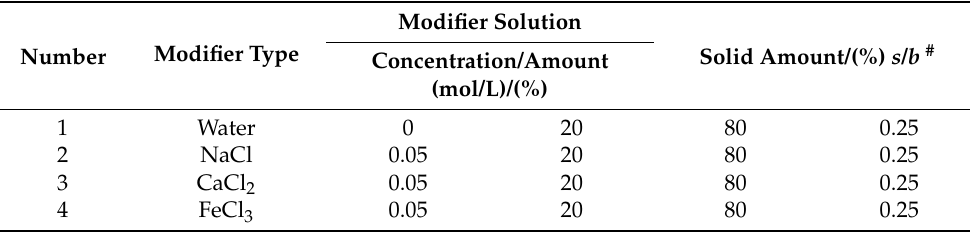
Table 3. Parameter of modified PS geopolymer